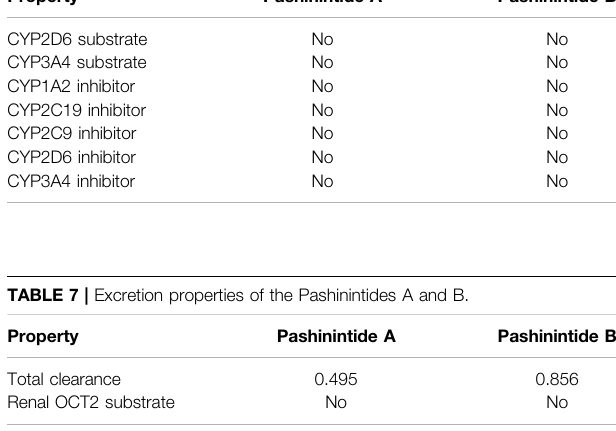
TABLE 6 | Metabolism properties of the Pashinintides A and B. Property